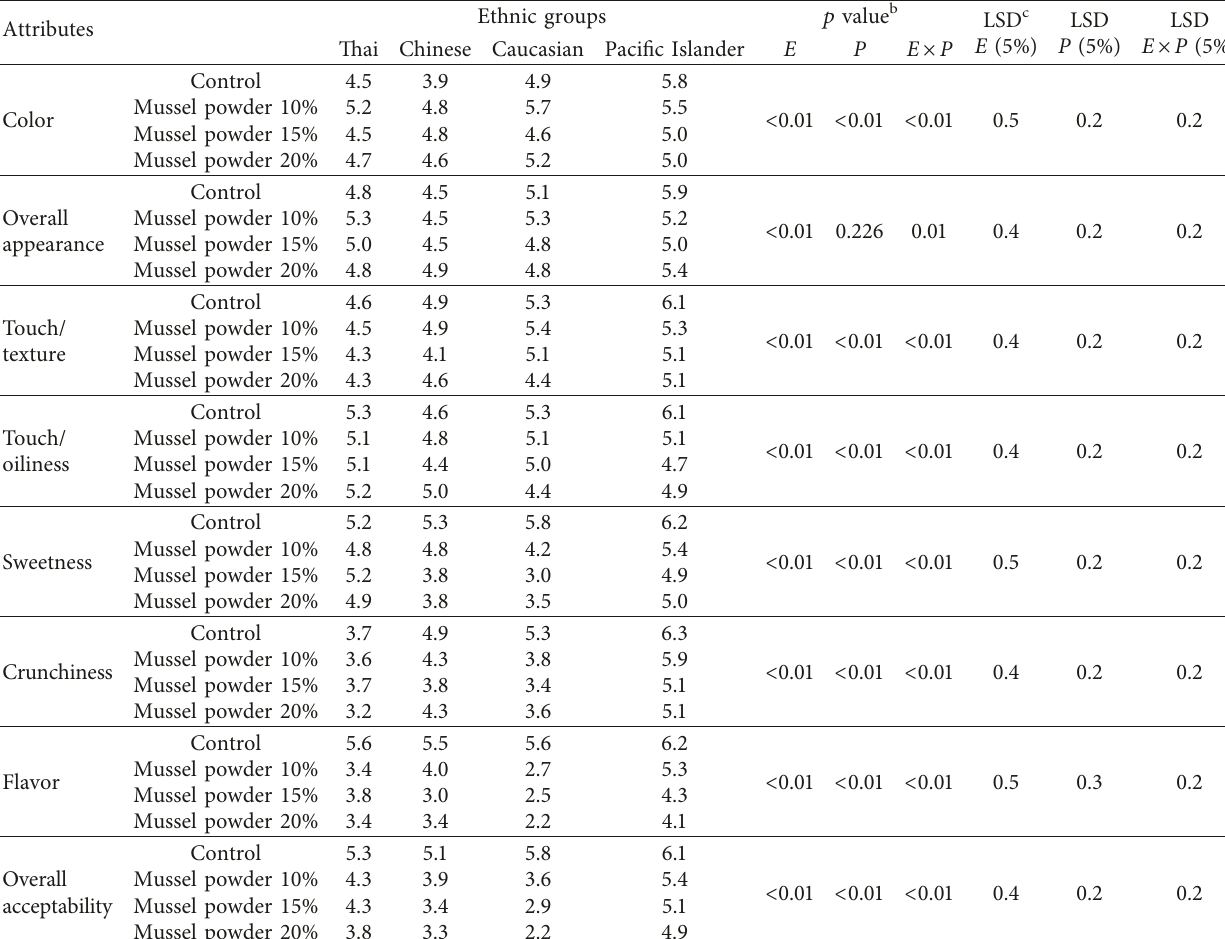
Table 5: Average value of sensory liking scores a of the four different ethnic groups (Thai, Chinese, Caucasian, and Pacific Islander) for the four different fortified